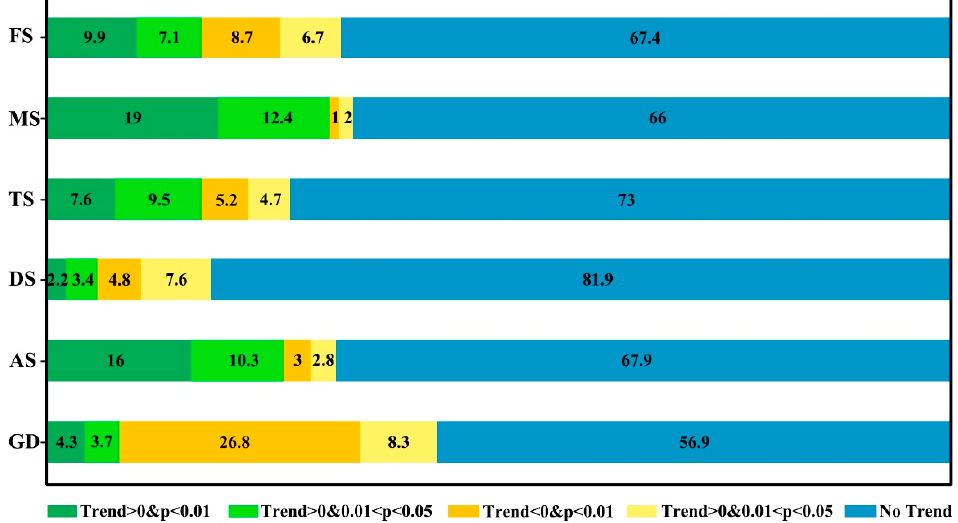
Figure 4. Proportion of NDVI change in different vegetation types: Forest (FS), Meadow steppe (MS), Typical steppe (TS), Desert steppe (DS), Alpine steppe (AS), and Gobi Desert (GD). The numbers refer to the percentage.